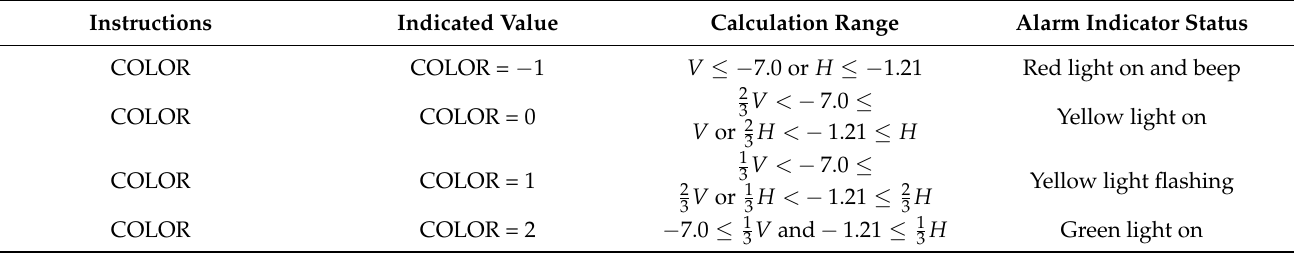
Table 5. Alarm feedback output